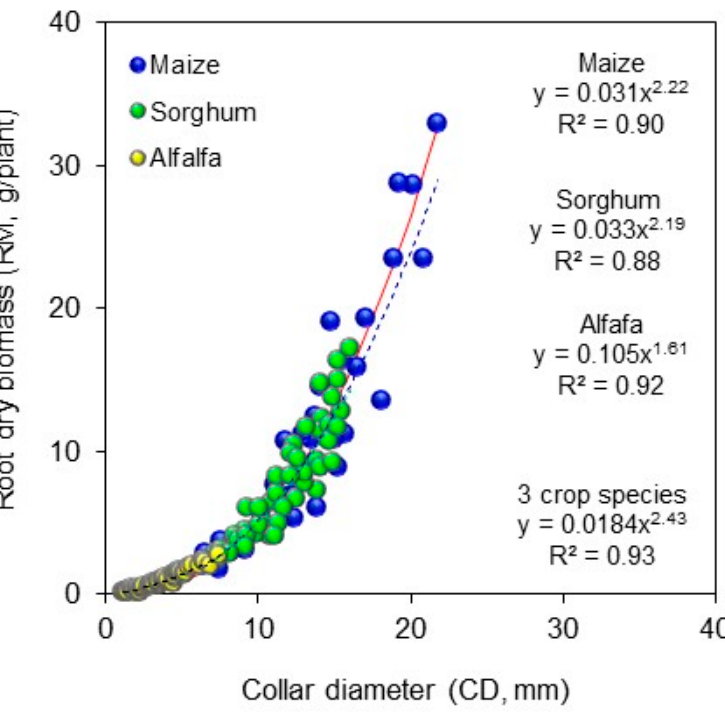
Figure 1. Relation between Root biomass (RM) and collar diameter (CD) of crops.